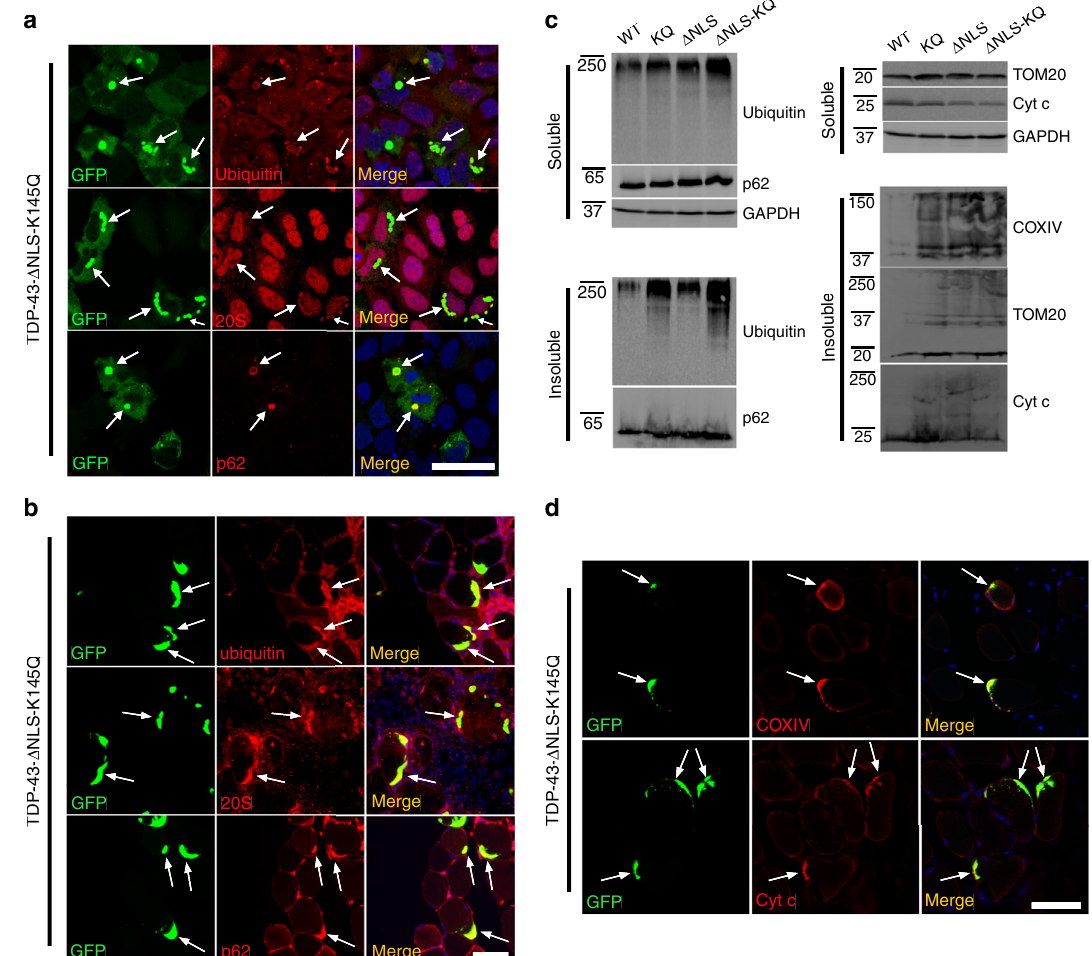
Fig. 3 TDP-43 acetylation-mimic aggregates recruit the degradative machinery and promote mitochondrial dysfunction. a Cells expressing aggregate-prone TDP-43- Δ NLS-K145Q were analyzed by double-labeling using ubiquitin, 20S proteasome, or p62 antibodies, and counterstained with DAPI ( blue ). White arrows highlight co-localization of ubiquitin, 20S proteasome, or p62 with TDP-43 aggregates. b Mouse TA muscles electroporated with TDP-43- Δ NLS-K145Q for 14 days were similarly analyzed using ubiquitin, 20S proteasome, and p62 antibodies. White arrows highlight prominent co-localization of TDP-43 aggregates with ubiquitin, 20S proteasome, or p62 in mouse muscles. c , d Mouse tissues were analyzed by immunoblotting ( c ) or microscopy ( d ) using ubiquitin or p62 antibodies, as well as the mitochondrial panel of antibody markers (COXIV, TOM20 and Cytochrome c). Scale bar = 50 μ